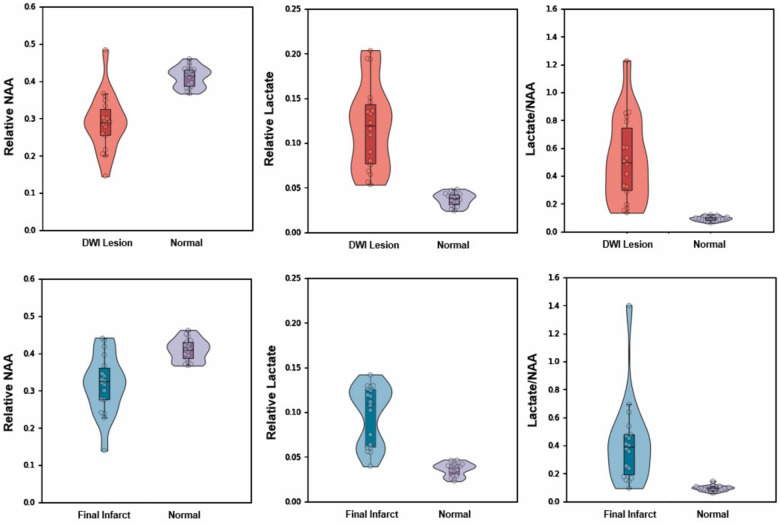

Comparisons of mean relative NAA, lactate, and lactate/NAA between DWI lesion versus normal tissue (top) and between final infarct versus normal tissue (bottom). Boxes indicate the interval between 25th and 75th percentiles; horizontal lines indicate median values; whiskers indicate the interval between 1.5 times the interquartile range above the 75th percentile and the corresponding distance to the 25th percentile value. Violin plots show the distribution of the data using kernel density estimation with automatic bandwidth selection.